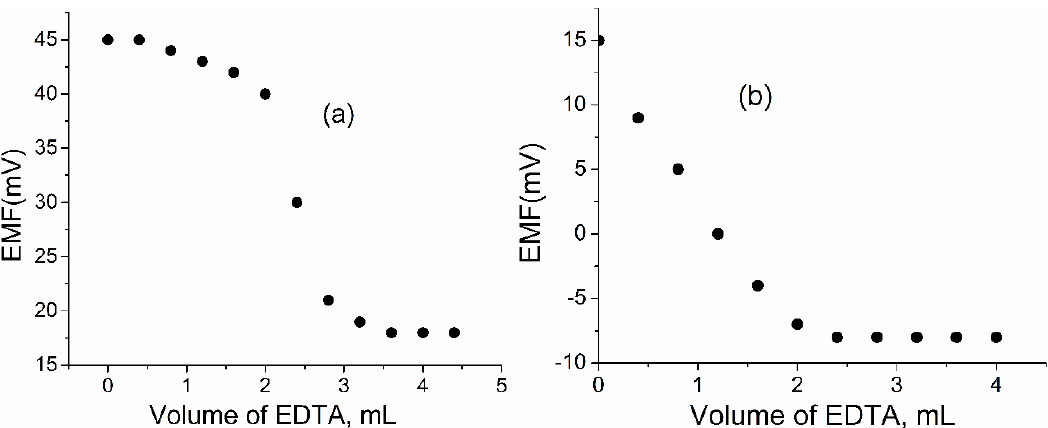
Figure 7. Potentiometric titration of ( a ) Zn(II) (25 mL of 1 × 10 − 2 M) with EDTA (1 × 10 − 1 M) using Zn(II)-selective electrode based on DPA and ( b ) Ni(II) (20 mL of 1 × 10 − 2 M) with EDTA(1 × 10 − 1 M) using Ni(II)-selective electrode based on TPA.